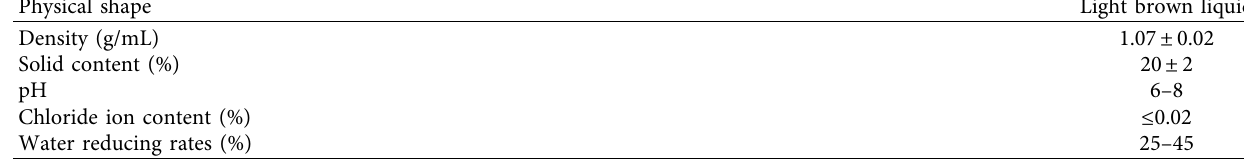
Table 6: Performance indexes of polycarboxylic acid